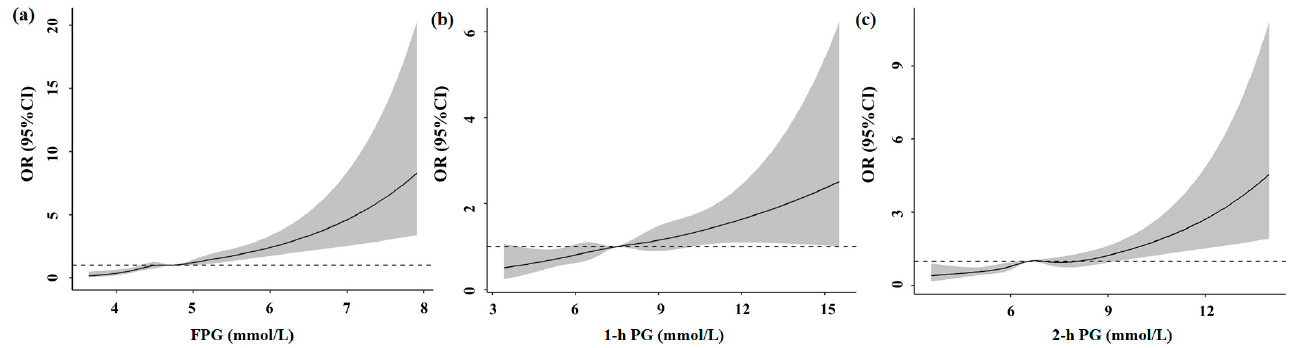
Figure 2. Association of blood glucose levels with macrosomia by restricted cubic spline. With the increase of FPG ( a ), 1-h PG ( b ) and 2-h PG ( c ), the odds ratios of macrosomia showed a non-linear upward trend.